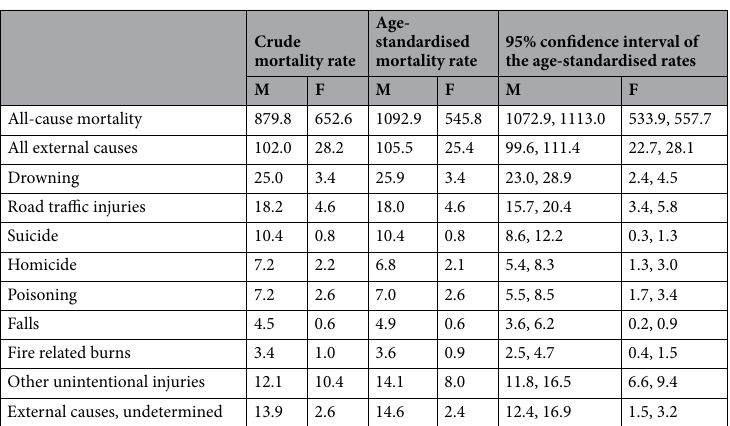
Table 2. Crude and age-standardised mortality rates by age and sex in 1989–2018. M males; F females.